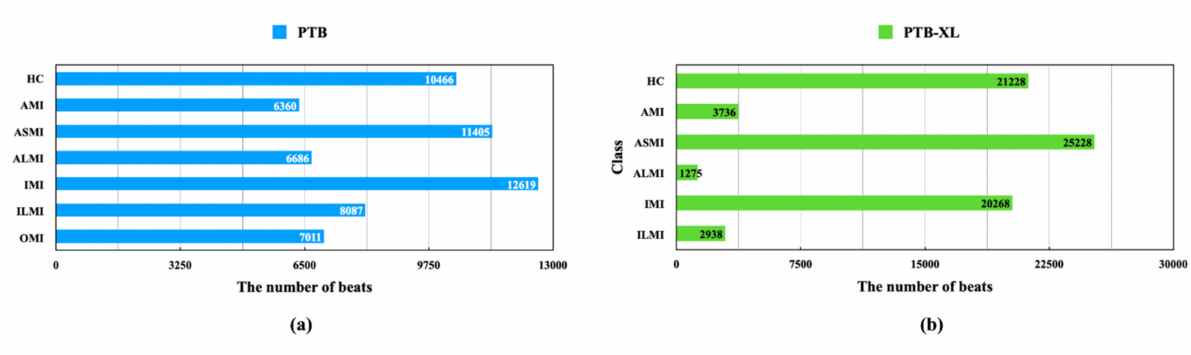
Figure 3. The statistic information of the 2 used databases. ( a ) PTB ( b )